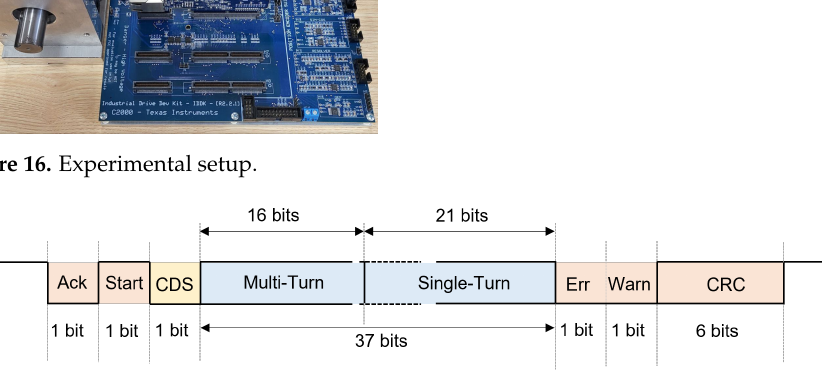
Figure 17. Internal data of BiSS-C data field for PM-FLC08AMK motor encoder.